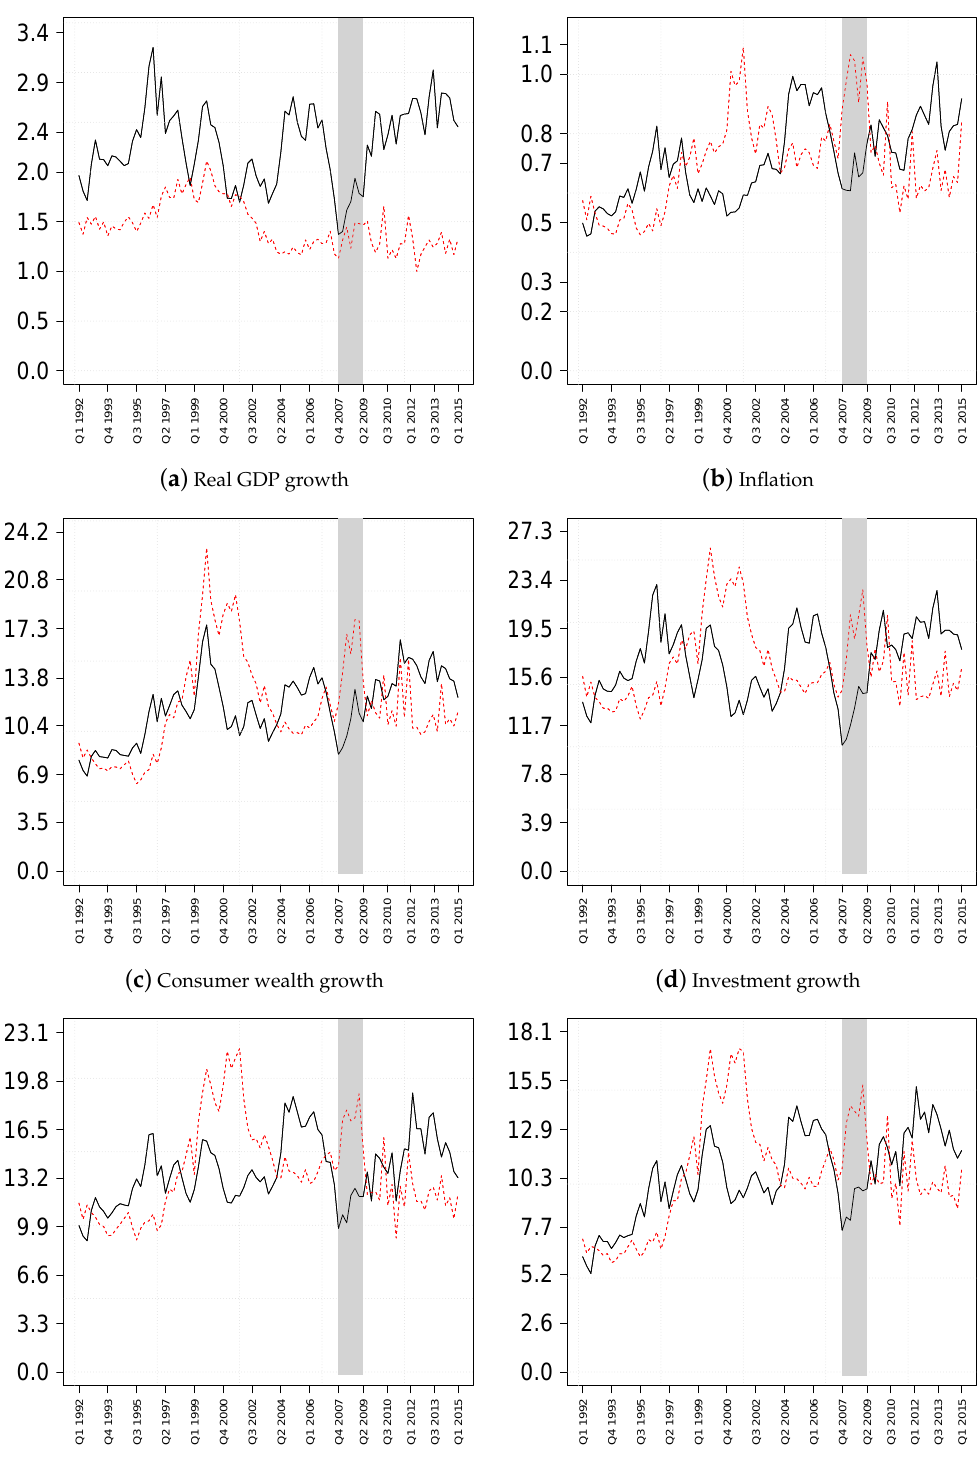
Figure 7. Elasticity of cumulative response to size of shock on impact; investment growth included. Notes: The figure shows the ratio of the cumulative response of a particular variable to the impact shock of the conventional monetary policy shock (black, solid line) and the spread shock (red, dashed line). Elasticities are in absolute terms. The shaded grey area indicates the period of the recession associated with the global financial